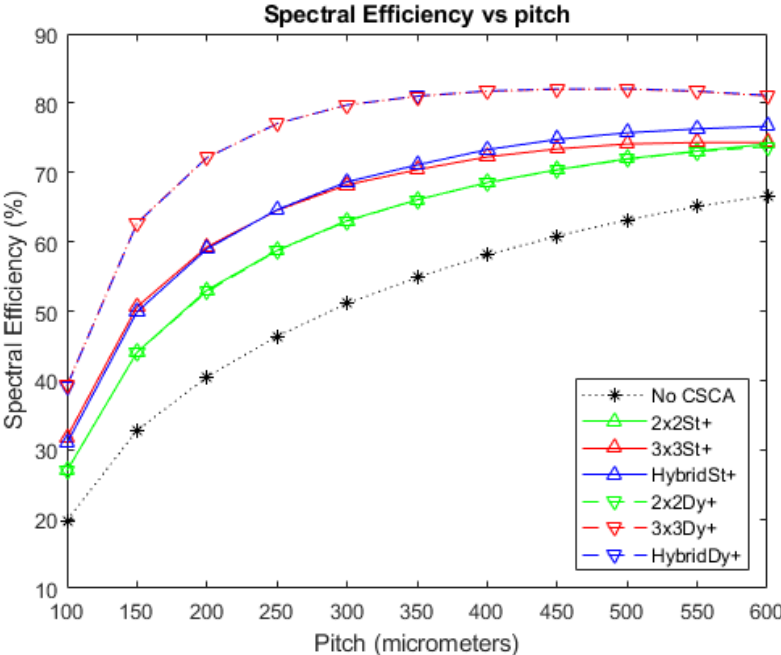
Figure 11. A plot of BSE versus pixel pitch at an incident photon flux of 10 6 photons mm −2 s −1 . The dynamic Hybrid and dynamic 3 × 3 CSCAs perform indistinguishably according to this metric, resulting in significant overlap. The same is true for the dynamic 2 × 2 and static 2 × 2 CSCAs. Similarly, the static Hybrid and static 3 × 3 CSCAs overlap significantly at lower fluxes but diverge from about ~300 µm. The case where no CSCA is applied is also shown as a reference.